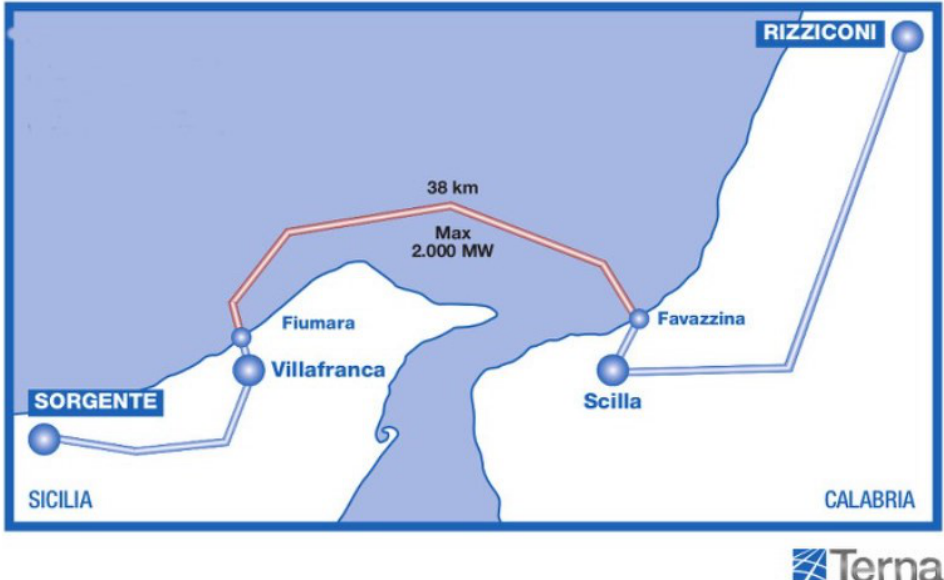
Figure 6. Route map of the AC 400 kV interconnection lines between Sicily and the Italian mainland: continuous lines represent overhead sections; dotted lines represent cable sections.